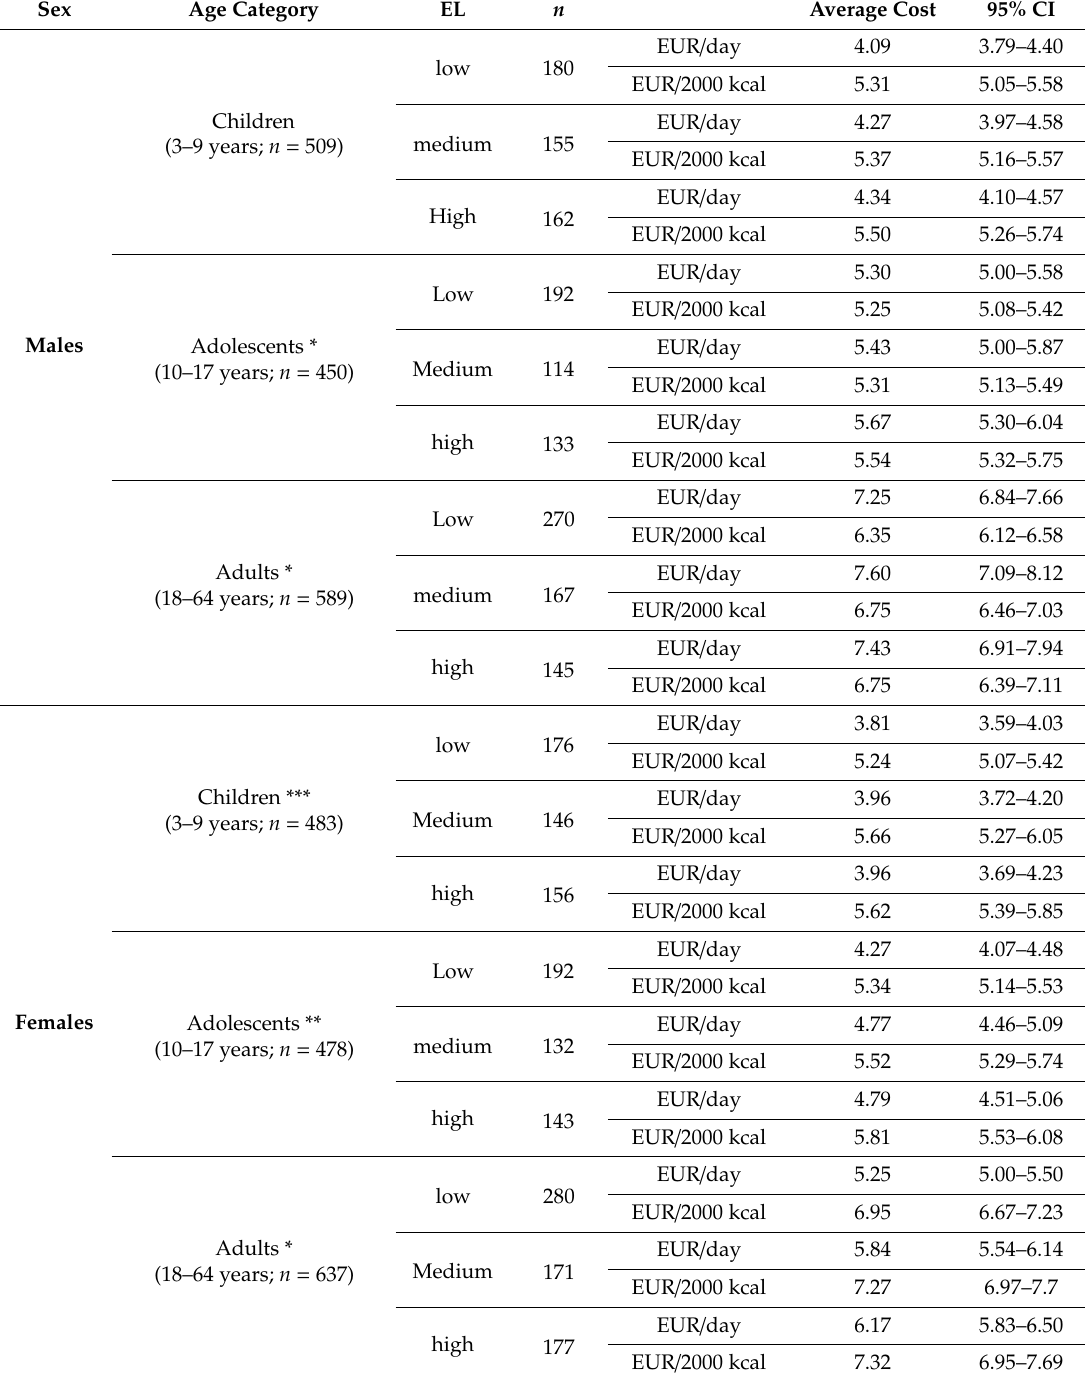
Table A2. Average total cost per day and average cost per 2000 kcal (including alcohol) for di ff erent age groups and by household education level (EL) in Belgium (Belgian national nutrition survey 2014 /